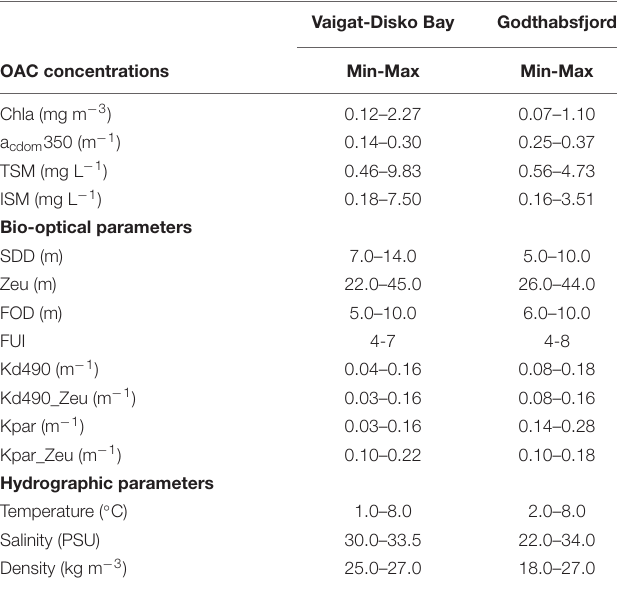
TABLE 2 | Variability in near-surface OAC concentrations, bio-optical parameters, and hydrographic parameter ranges measured in the Vaigat-Disko Bay and Godthabsfjord along southwest coast of